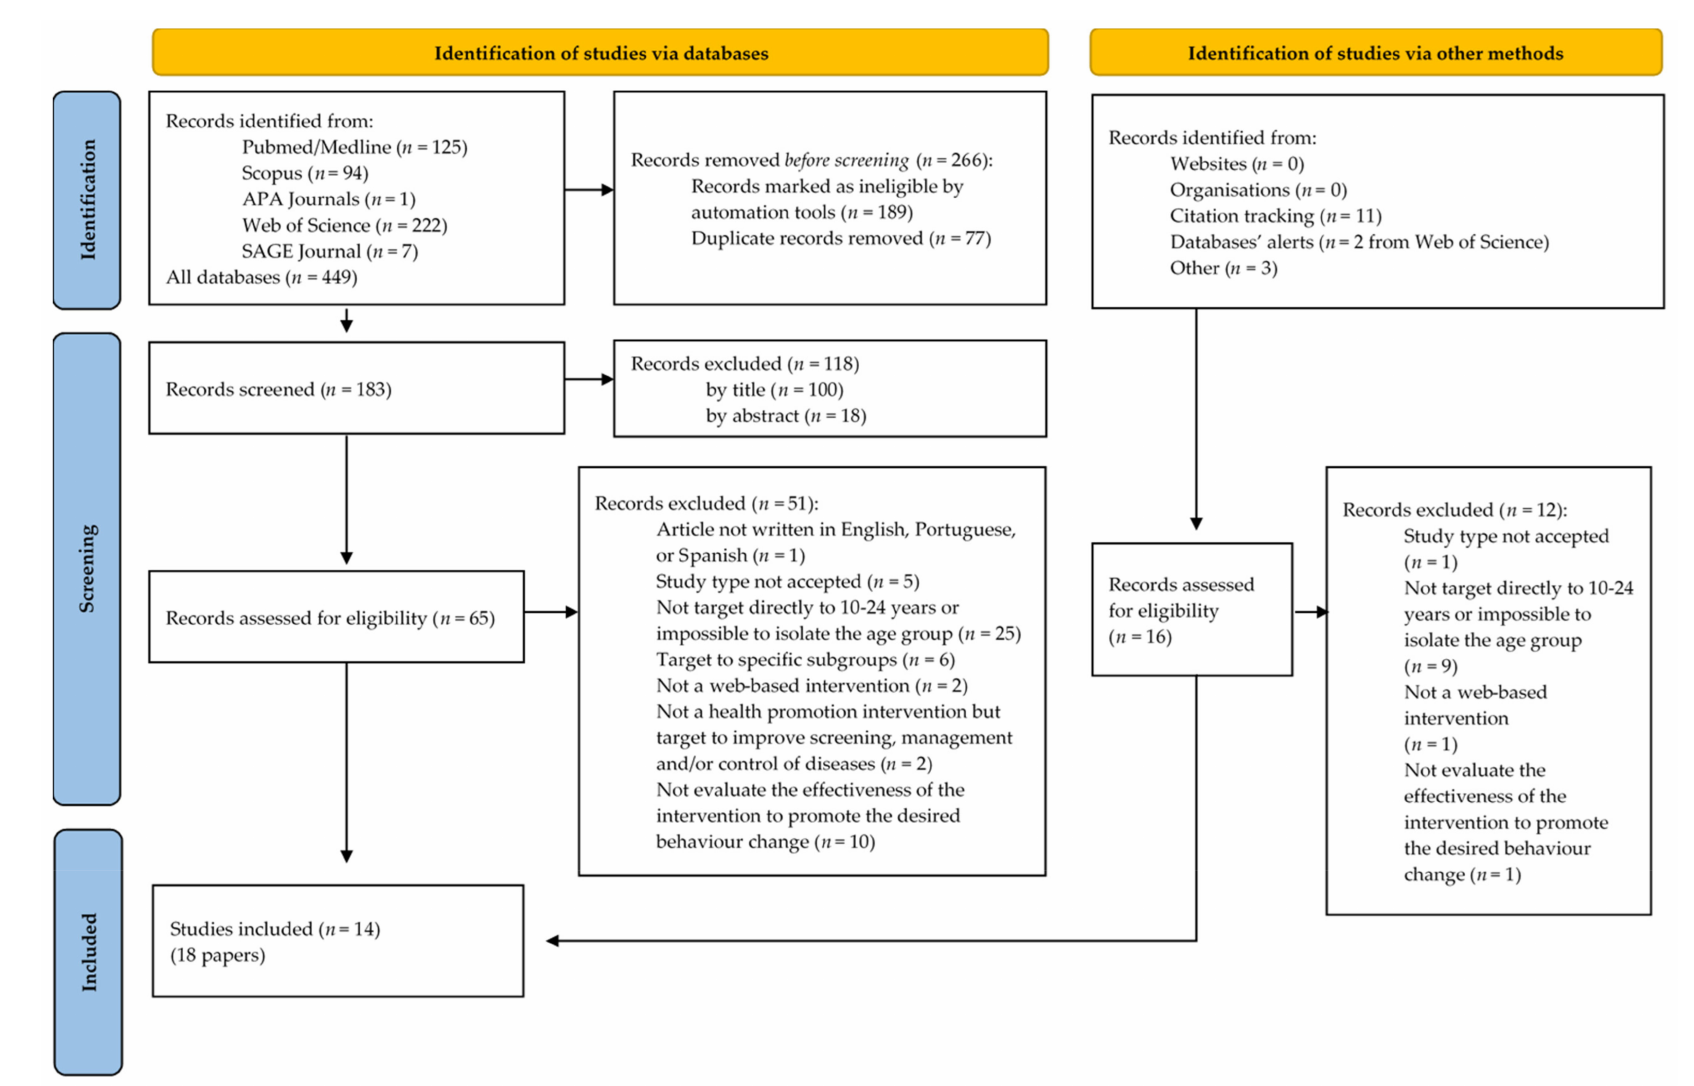
Figure 2. Study Flow Diagram adapted from: [18]. For more information, visit: http://www.prisma-statement.org/ (accessed on 29 January